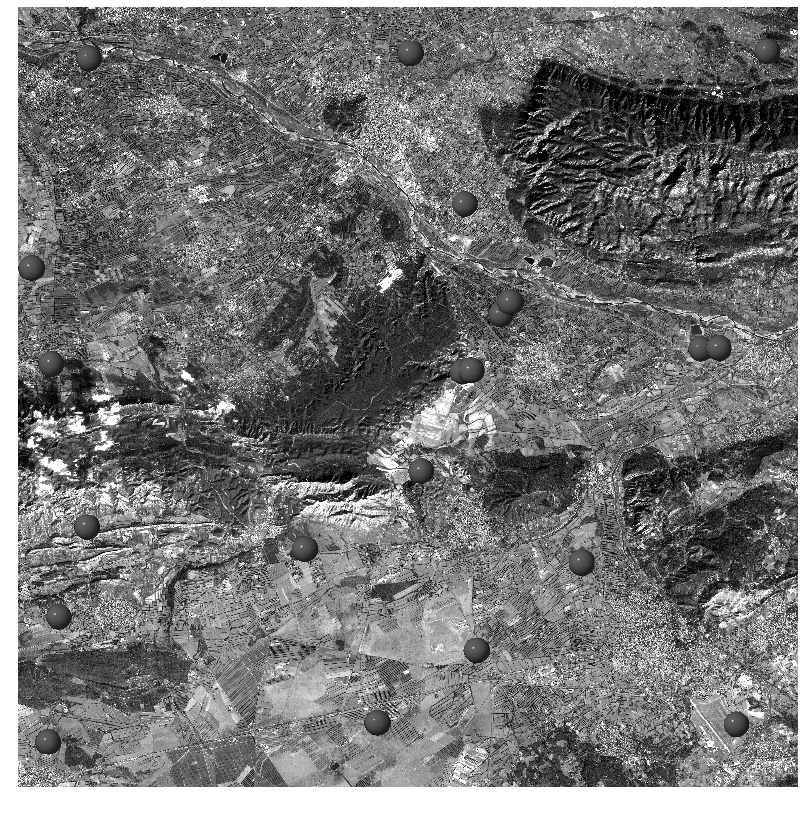
Figure 8. Cartosat-1 Aft image collected over Salon de Provence (France) with superimposed the GCPs derived from the French DB ORTHO® database provided by the Principal-Investigator French Institut Géographique